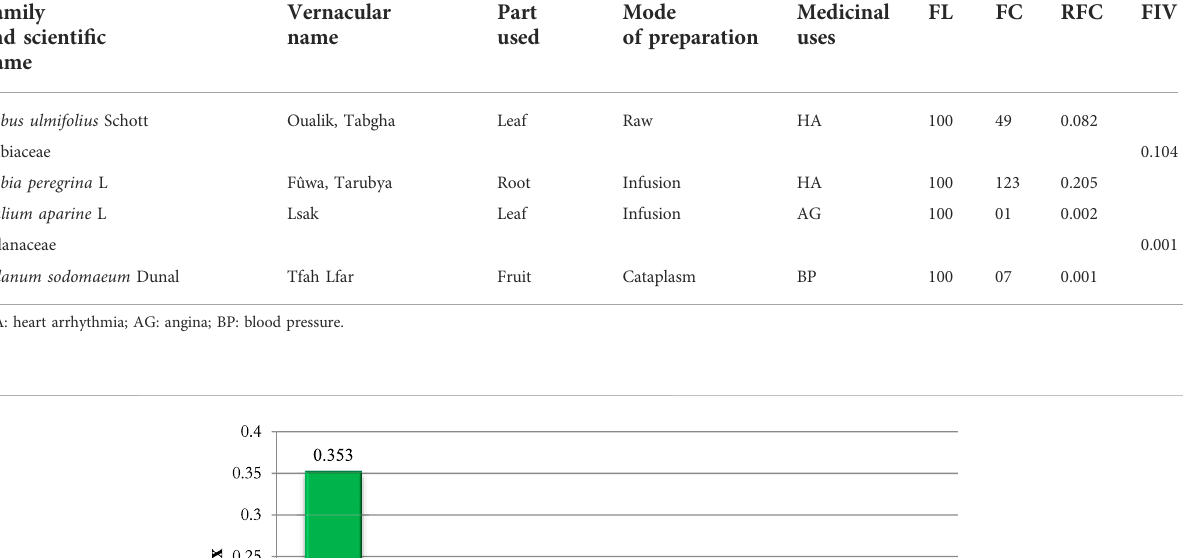
TABLE 2 ( Continued ) List of medicinal and aromatic plant actives on the cardiovascular diseases in the Moroccan Rif region. Family